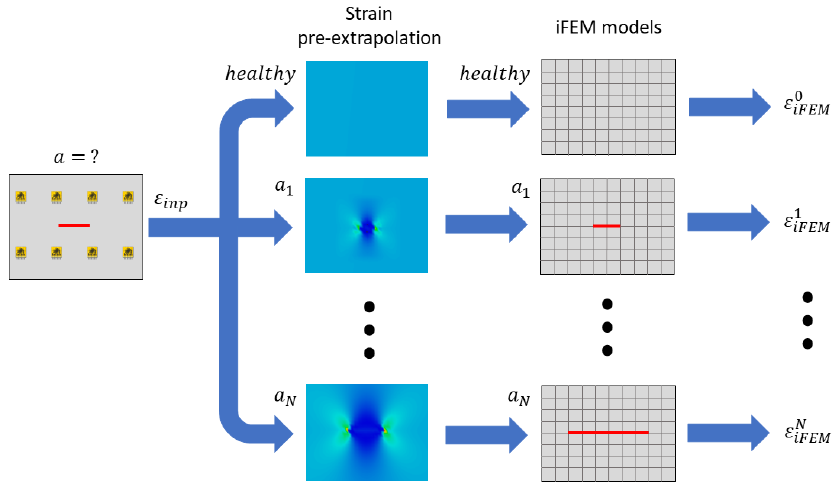
Figure 6. Strain pre-extrapolation framework.